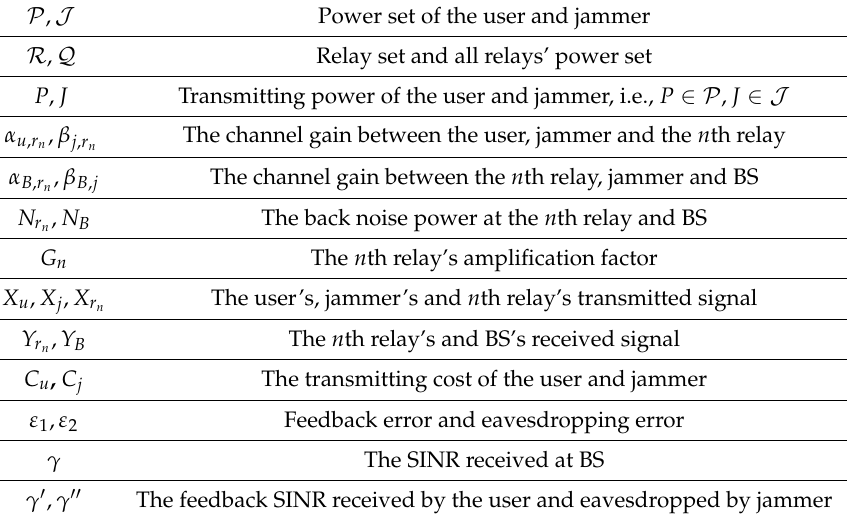
Table 1. Summation of used